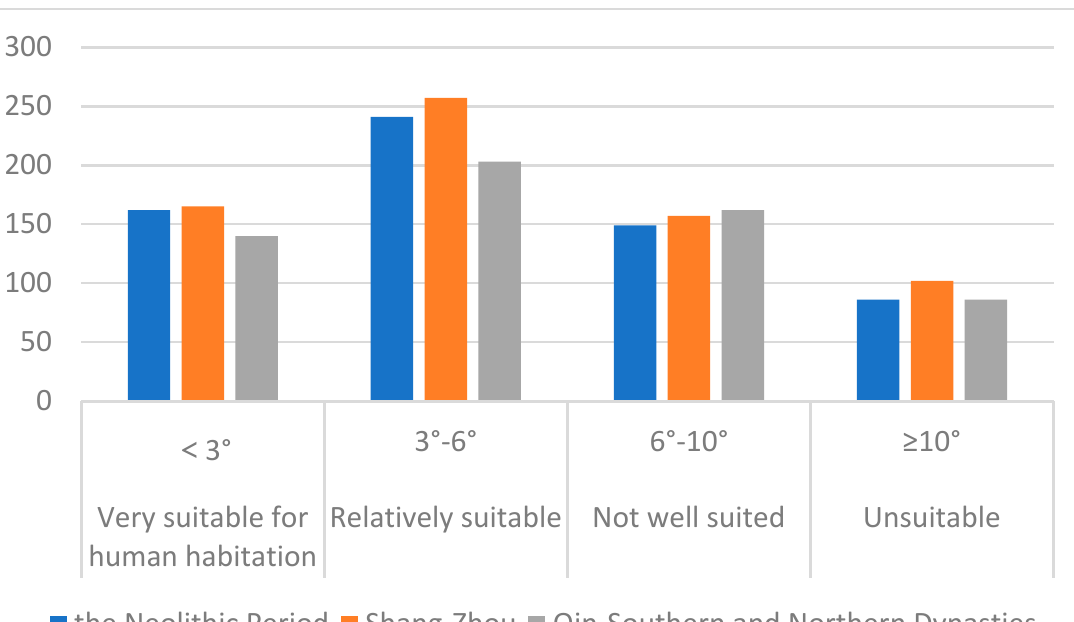
Figure 10. Slope statistics of the distribution of settlements in different periods.